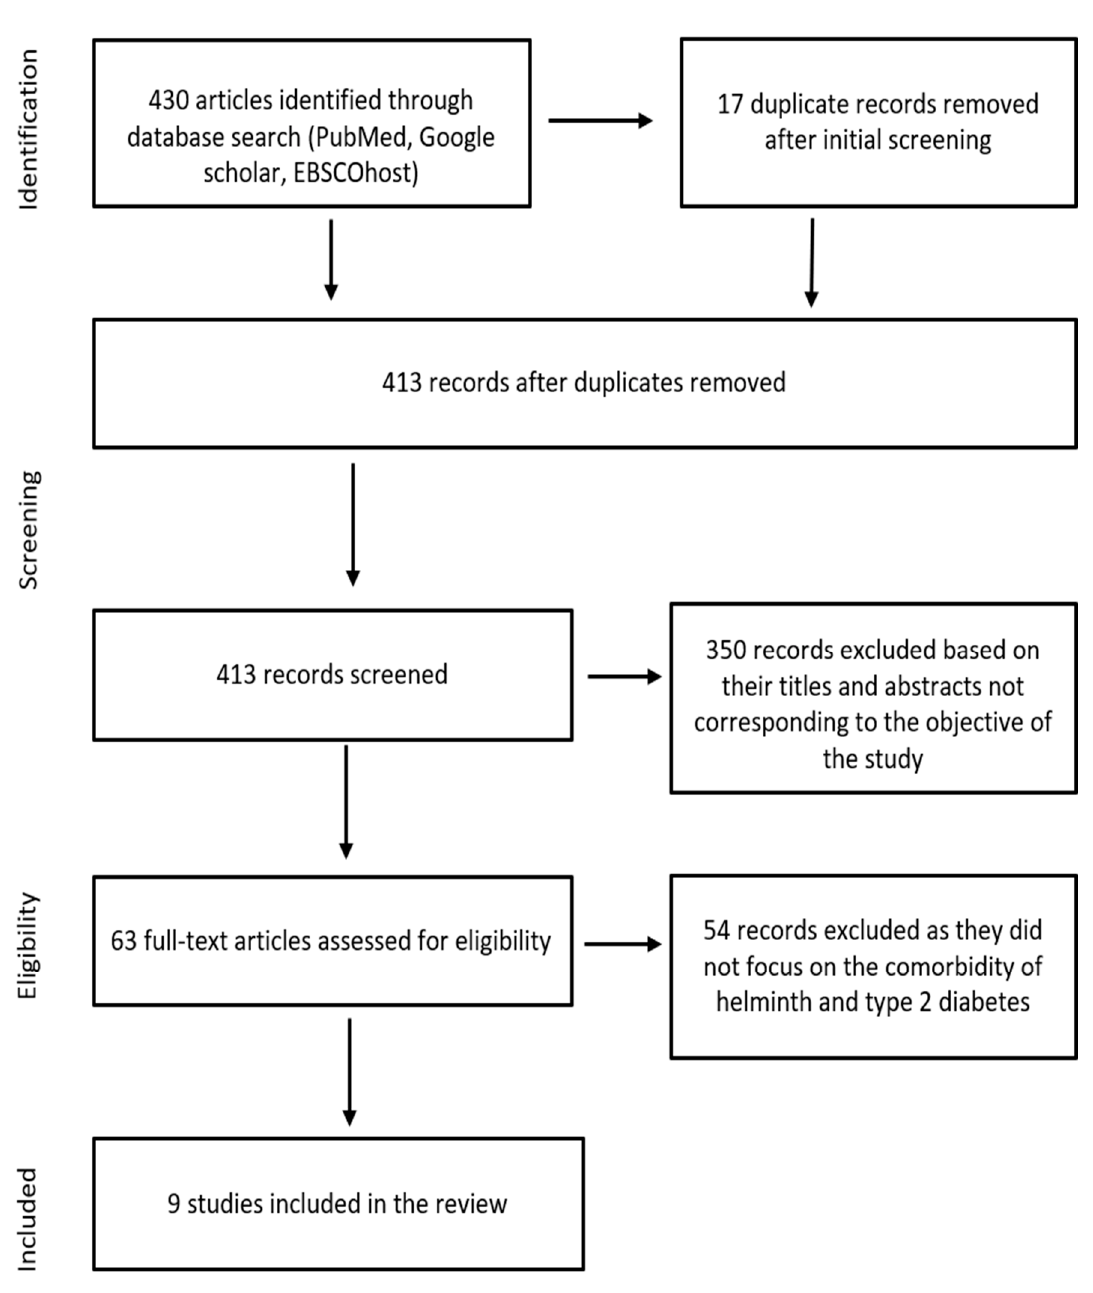
Figure 1. PRISMA diagram.